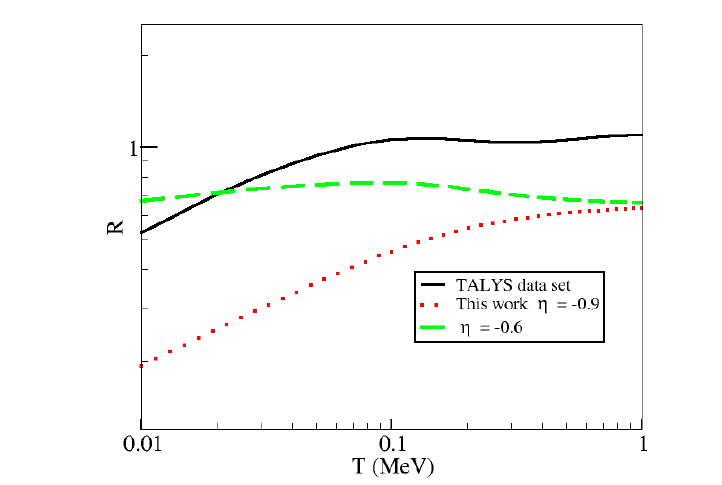
Figure 4. R calculations for 39 Mg. All integrals are done numerically with cross sections, as explained in the